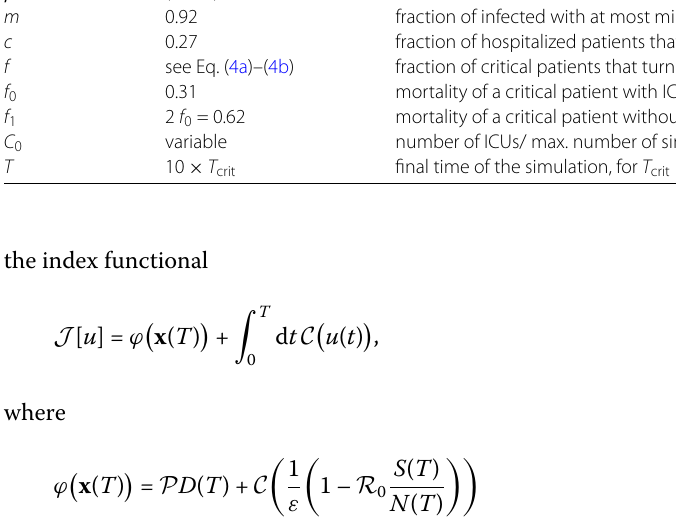
Table 1 List of parameters used in the simulations. See Appendix C for details Symbol Value Description R 0 2.7 basic reproduction number N (0) 83 × 10 6 initial population size γ –1 2.6d average latency time between exposure and infectious period l γ –1 2.35d average infectious period before recovery or hospitalization γ –1 h (1.15d) –1